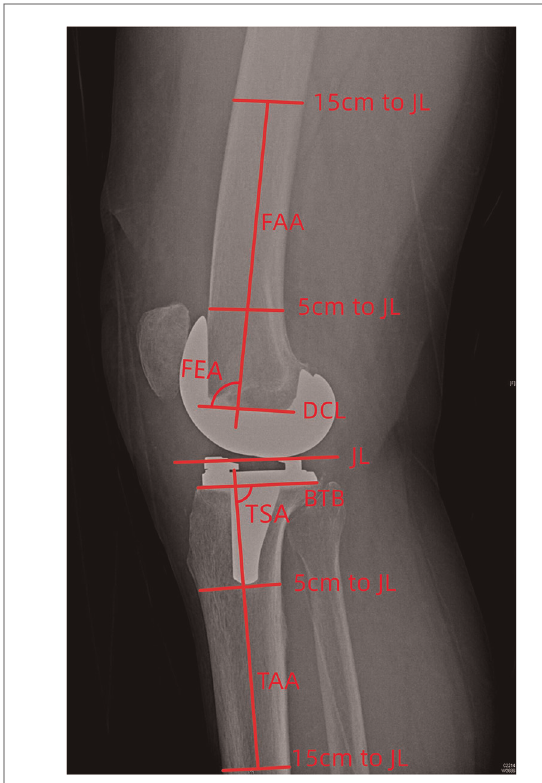
FIGURE 2 Measurement on the sagittal plane (JL, joint line; FAA, femoral anatomical axis; DCL, distal cutting line; BTB, border of tibial baseplate; TAA, tibial anatomical axis; FEA, femoral fl exion- extension angle; TSA, tibial posterior slope angle).